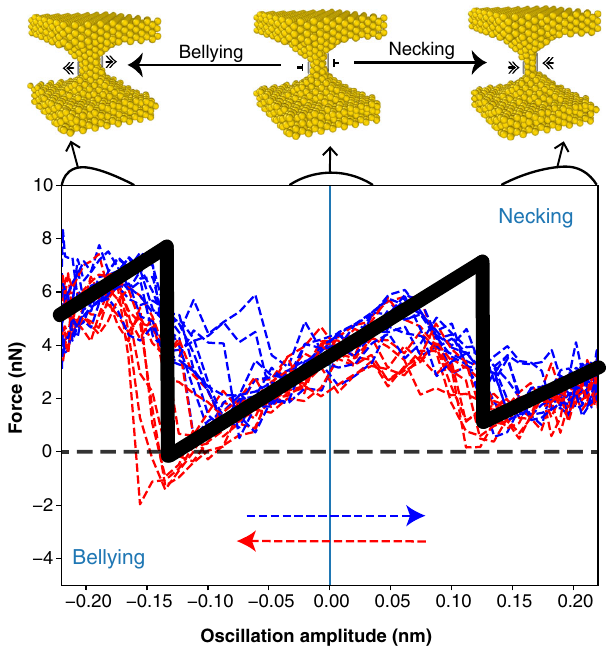
Fig. 4 Large amplitude force-strain characteristics. Simulation trajectories in the force-strain plane, for the N ≈ 9 nanojunction at 50 MHz. Blue trajectories: half cycle with positive strain time derivative d ϵ dt > 0; red trajectories: negative strain time derivative d ϵ dt < 0. Insets are snapshots frames showing the junction at rest (center), after necking (right) and after bellying (left). Black line: schematic adiabatic zig-zag force-strain characteristics. The straight tract near zero is (ignoring fl uctuations) the elastic regime. Major yielding slips occurs at necking and bellying, which are the results of forced tensile and compressive strain, respectively. Note the average tension force dominating the whole cycle, surprisingly including the compressive portion, and the large jumps where the force falls near zero at both